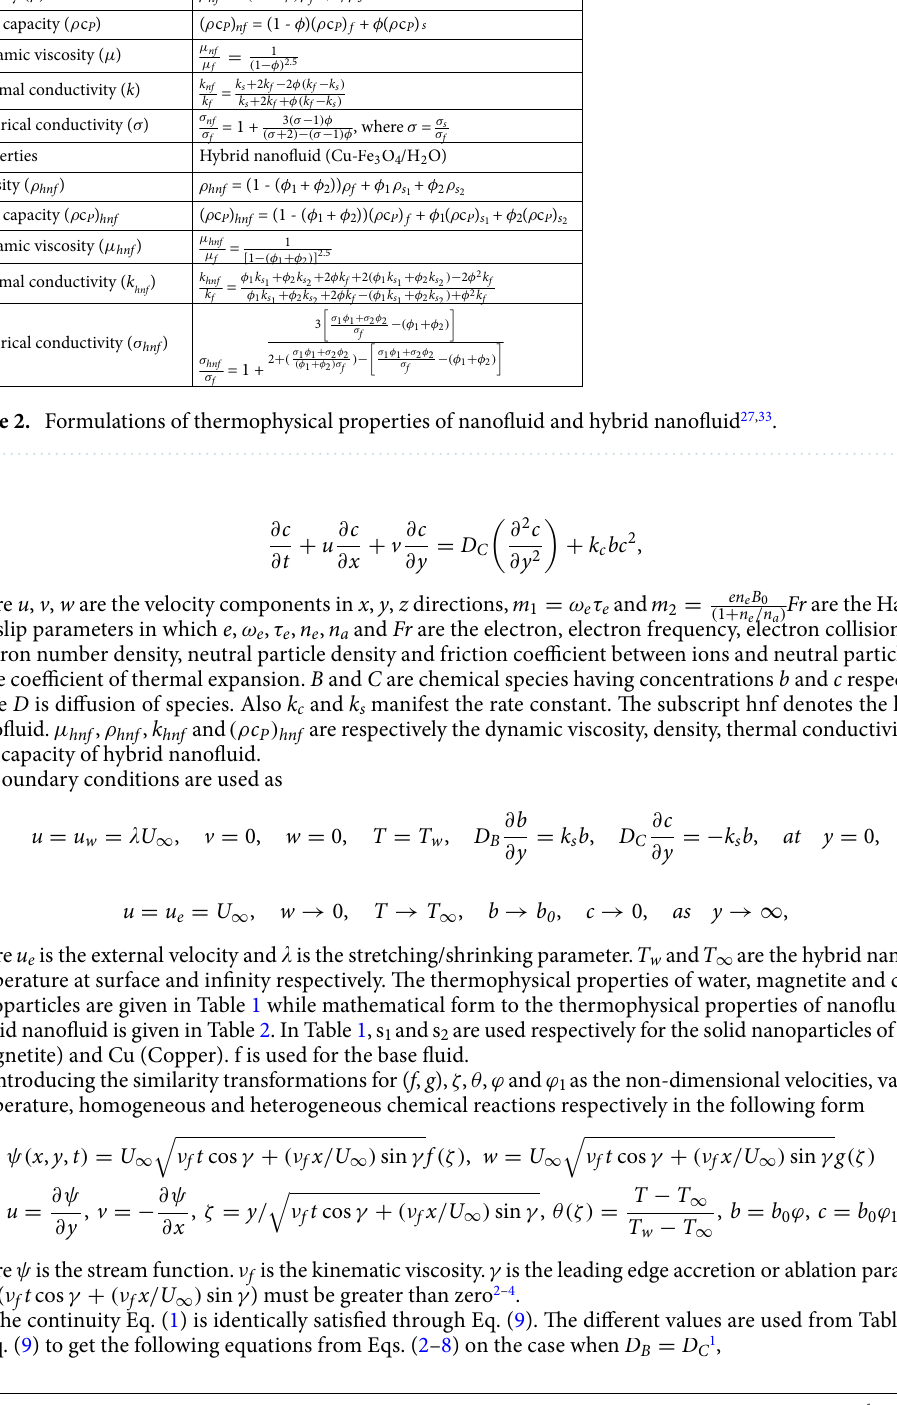
Table 2. Formulations of thermophysical properties of nanofluid and hybrid nanofluid 27,33 .